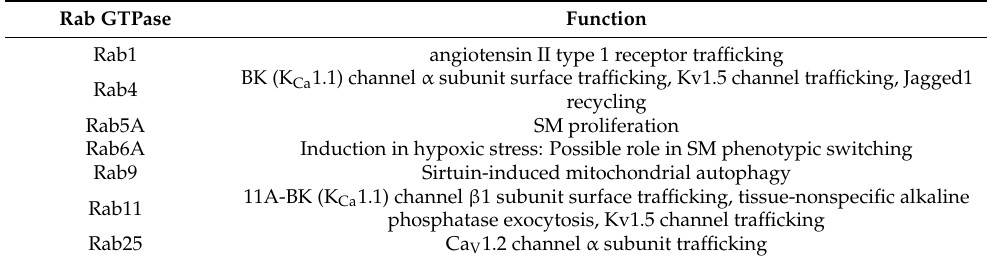
Table 2. Rab GTPases in vascular smooth